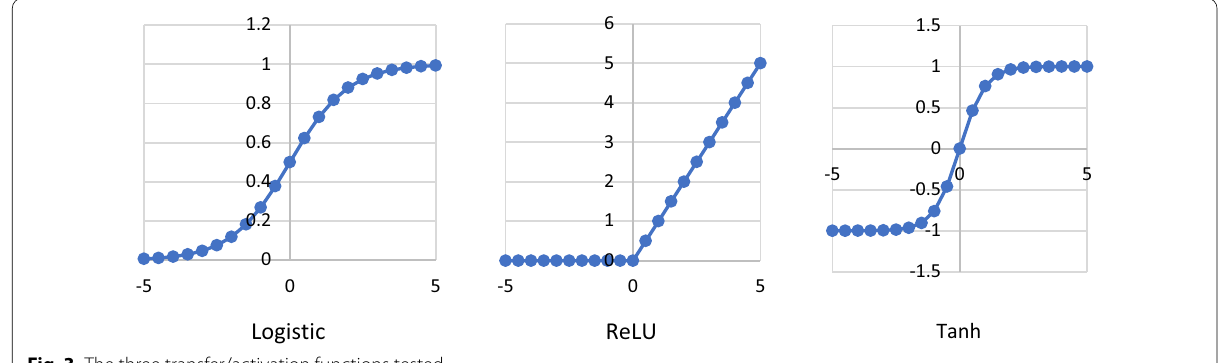
Fig. 3 The three transfer/activation functions